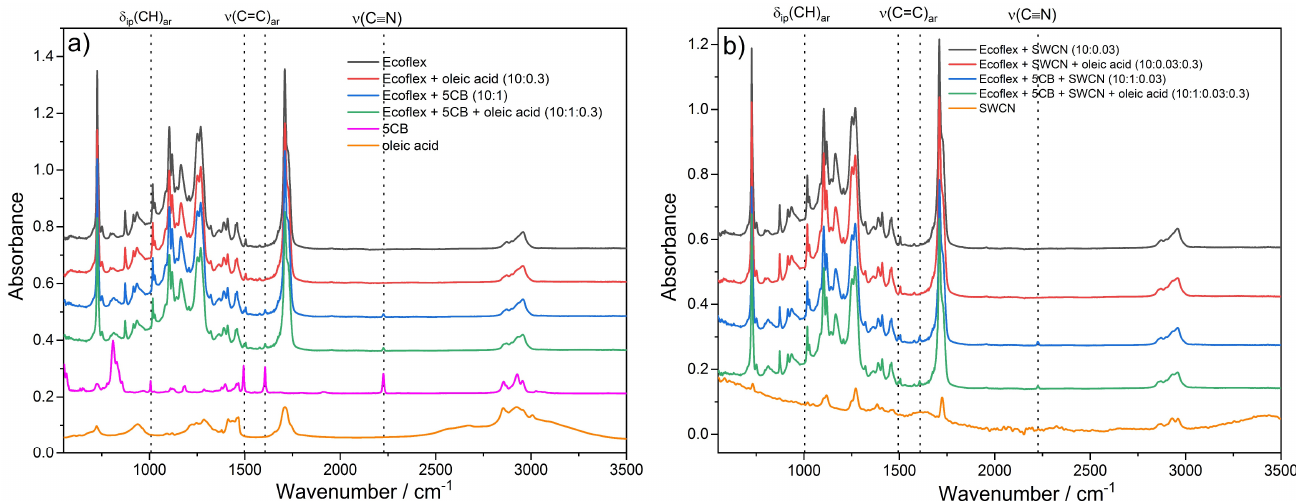
Figure 7. Comparison of Fourier transform infrared (FTIR) spectra of the created layers based on Ecoflex ® without ( a ) and with SWCN admixture ( b